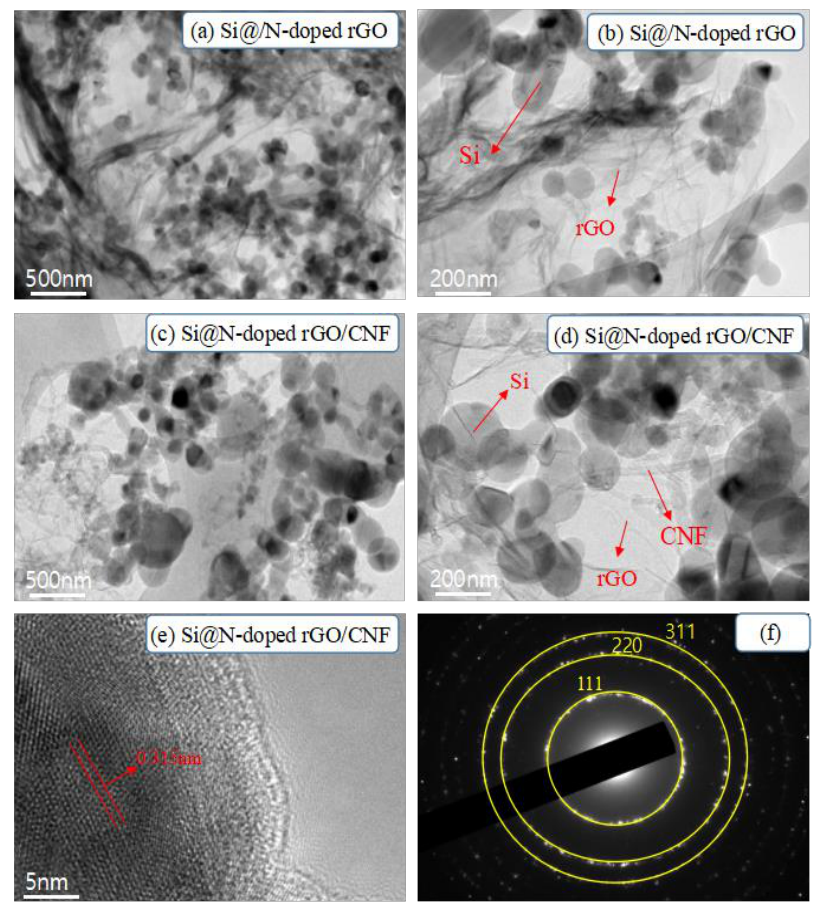
Figure 3. TEM images of Si@N-doped rGO ( a , b ), Si@N-doped rGO/CNF ( c , d ) composites, ( e ) High- resolution TEM images of Si@N-doped rGO/CNF composites, ( f ) Selected Area Electron Diffraction (SAED) pattern of Si.